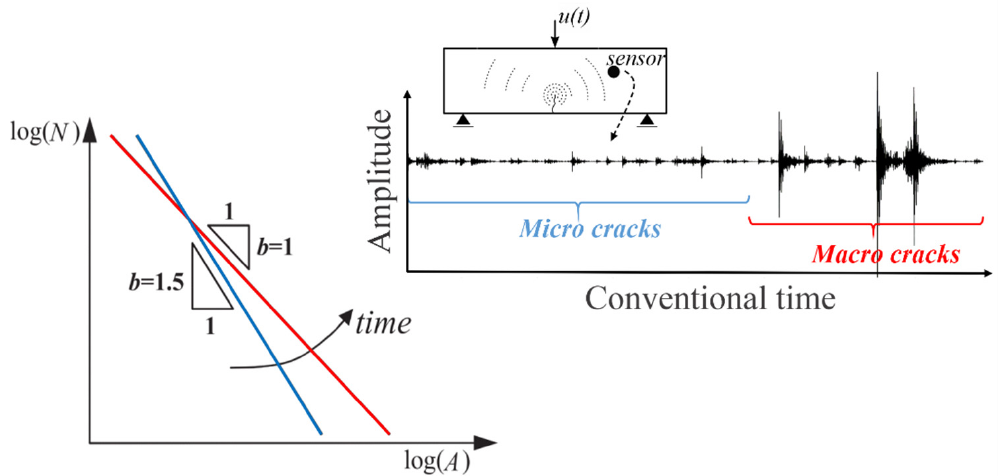
Figure 1. The b -value evolution and its physical meaning with respect to an acoustic emission sig- nal.